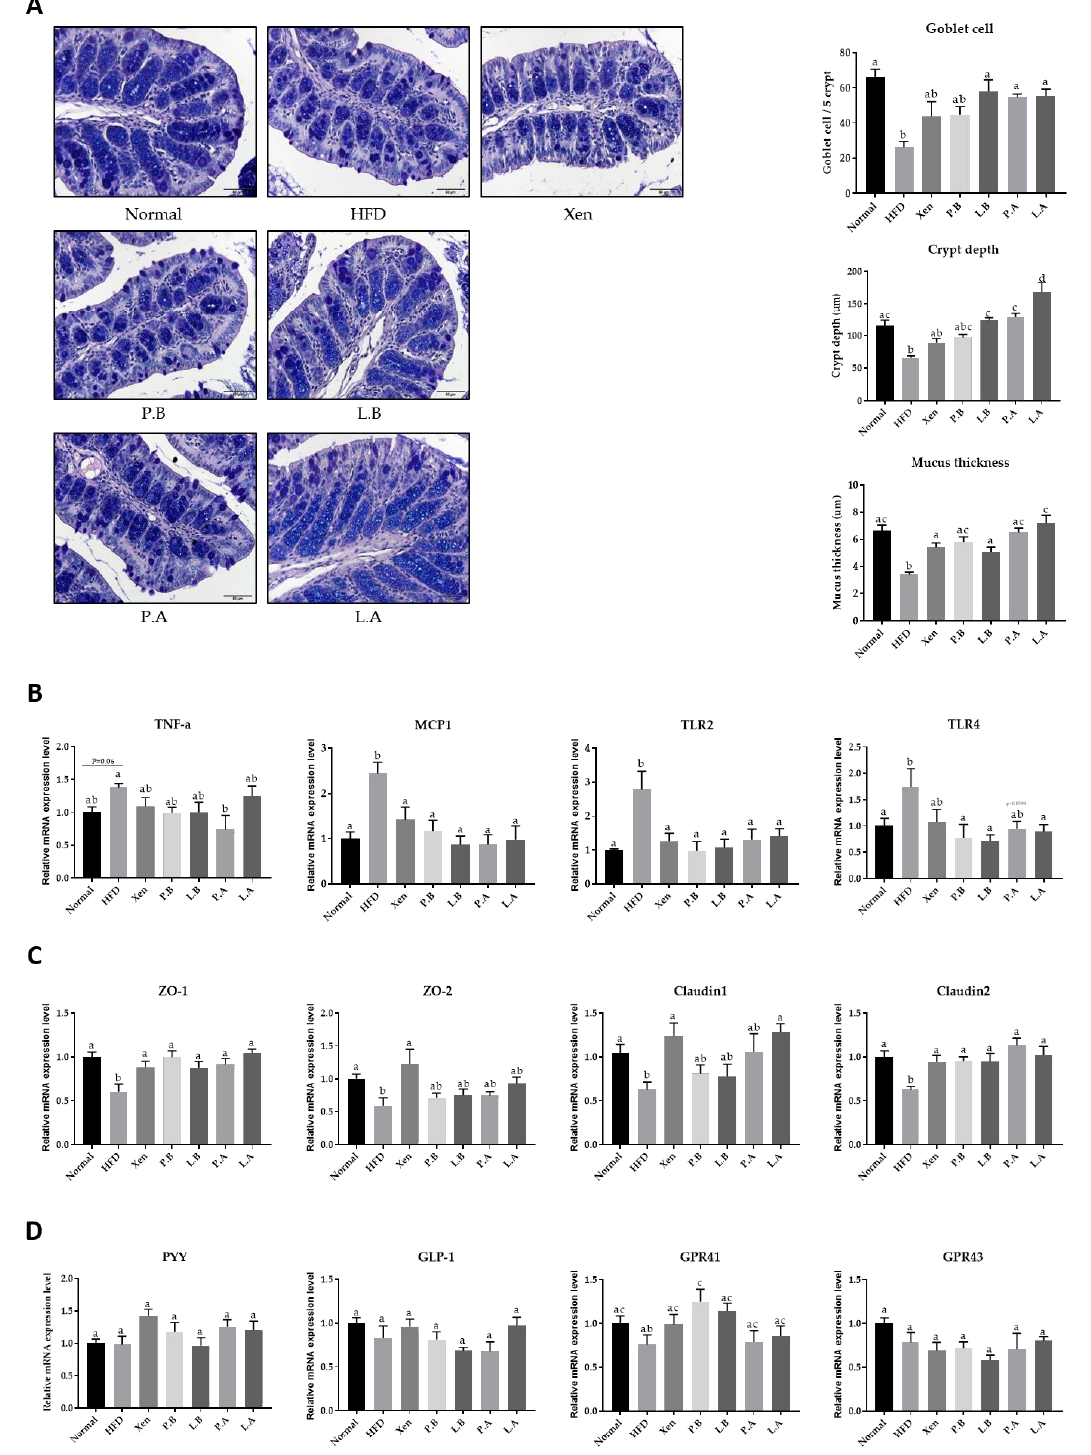
Figure 5. Administration of bacteria improved the intestinal structure, permeability and inflammation, but did not significantly change the levels of gene expression of appetite-regulating factors. ( A ) Histological analysis (AB-PAS staining) of the colonic tissue sections (magnification of 200 × ). ( B ) mRNA levels of TNF-a, MCP1, TLR2 and TLR4 as inflammation markers. ( C ) Representative gene expressions of ZO-1, ZO-2, Claudin1 and Claudin2 as permeability markers. ( D ) mRNA levels of the appetite markers PYY, GLP-1, GPR41 and GPR43. The data are expressed as means ± SD; the differences were statistically evaluated using one-way ANOVA. Means without a common letter significantly differ, p < 0.05. HFD, high-fat diet; Xen, orlistat, P.B, pasteurized BAA-835; L.B, live BAA-835; P.A, pasteurized A. muciniphila ; L.A, live A. muciniphila .